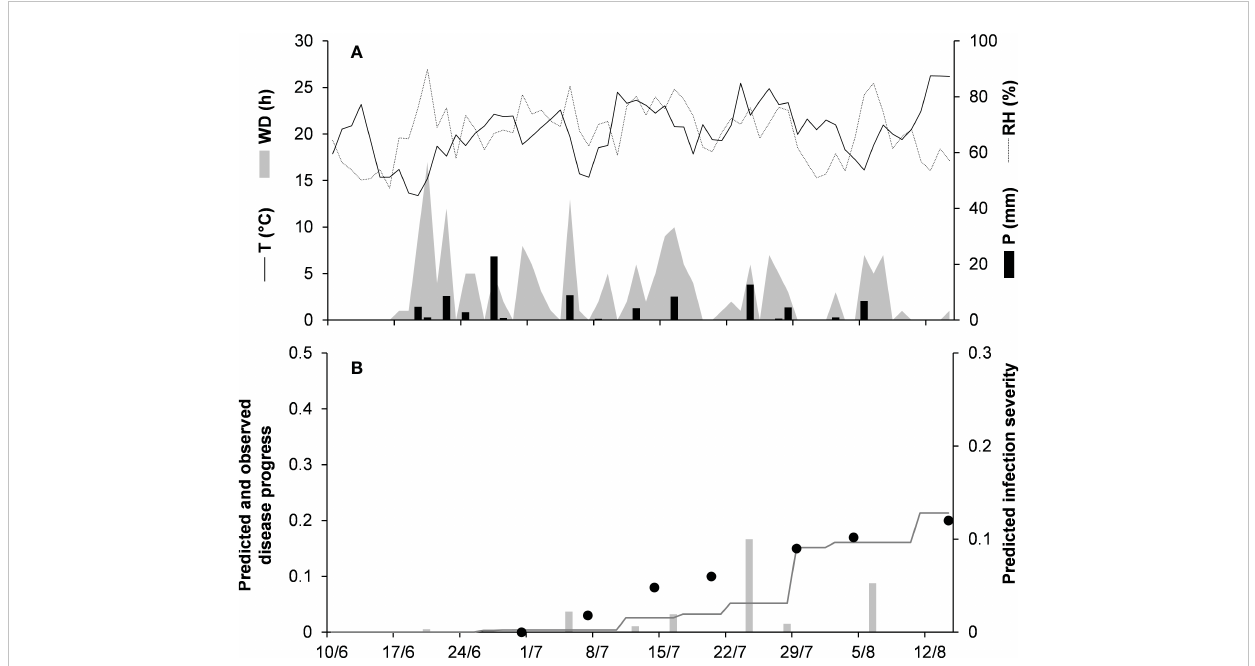
FIGURE 7 Predicted and observed disease progress on dry bean for the orbiculare clade in Morden, Manitoba, Canada, in 2015 (MA-15). (A) Weather variables: air temperature (T, °C, solid line), relative humidity (RH, %, dotted line), rainfall (P, mm, black bars), and wetness duration (WD, in h, gray area). (B) Infection severity predicted by the model (light gray bars), disease severity predicted by the model (dark gray line), and observed disease incidence (full